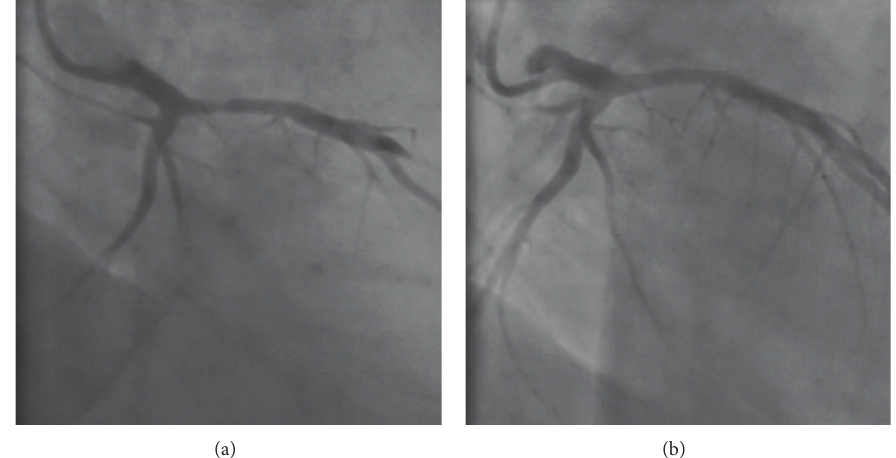
Figure 3: Coronary angiogram. (a) Coronary angiogram showing a 70% stenosis, haziness, and spasm of the left anterior descending artery (LAD). (b) The stenosis disappeared after intracoronary nitroglycerine